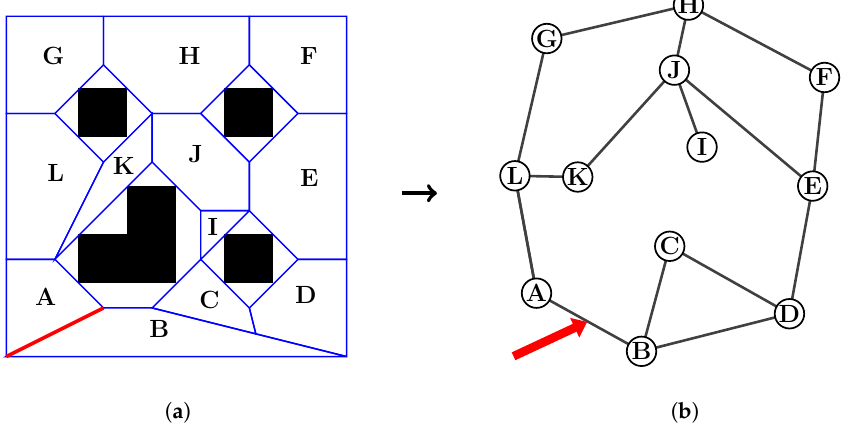
Figure 3. Illustration of a polytope map of an environment with four obstacles (black) and its graph representation. ( a ) Sample polytope map; ( b ) graph representation of the polytope map.